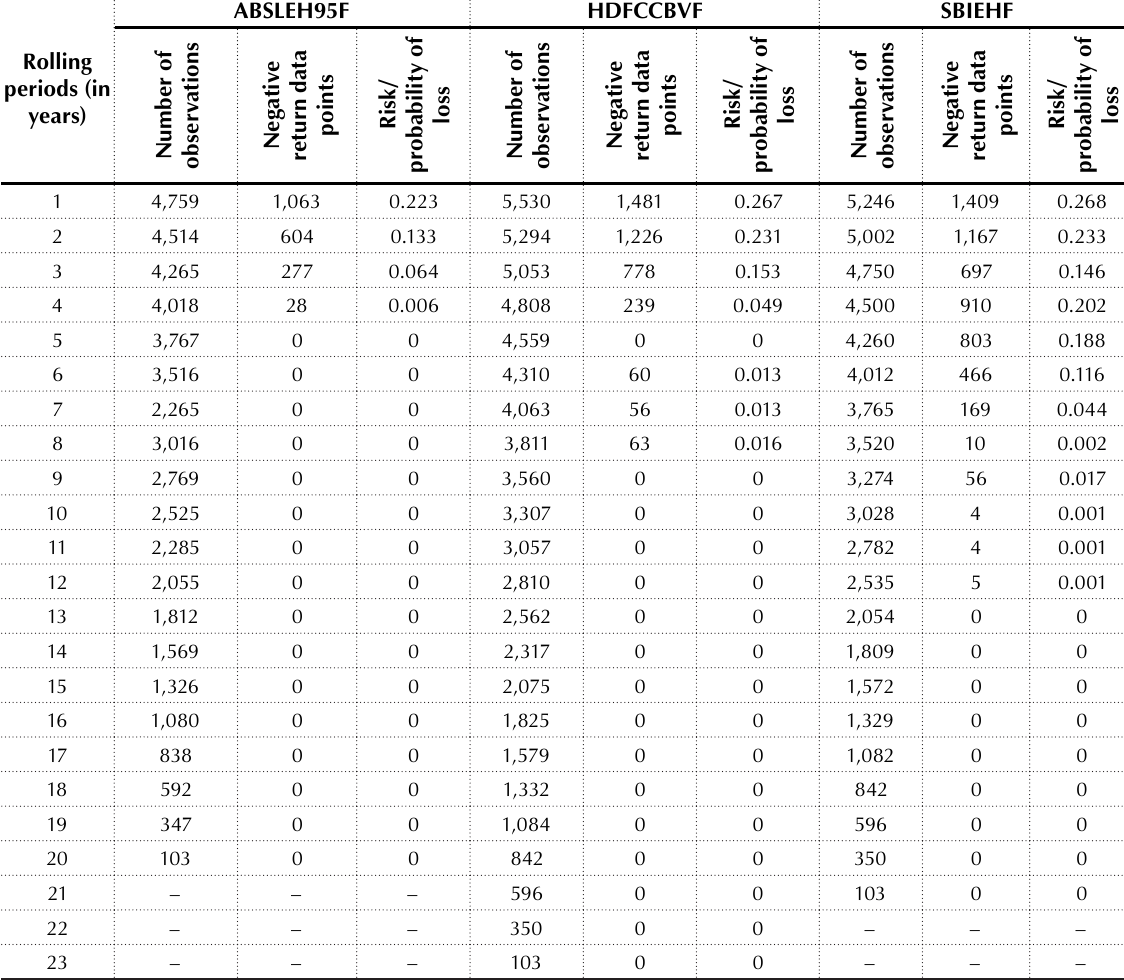
Rolling periods (in